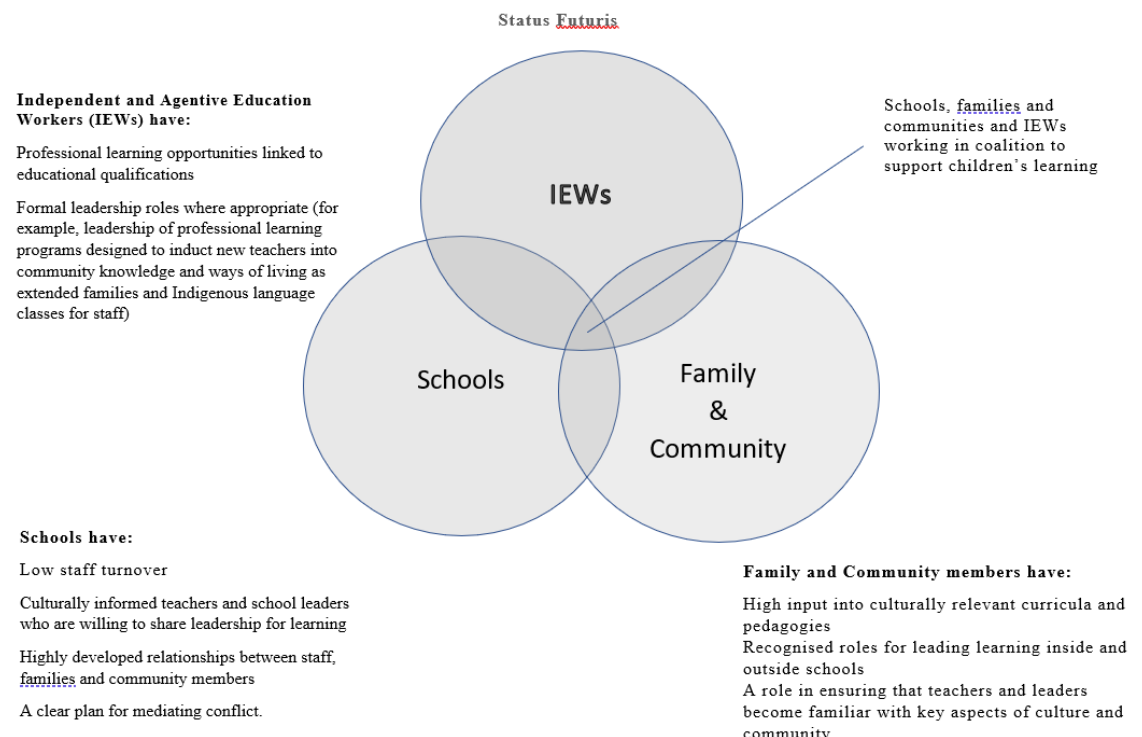
Figure 2. Status